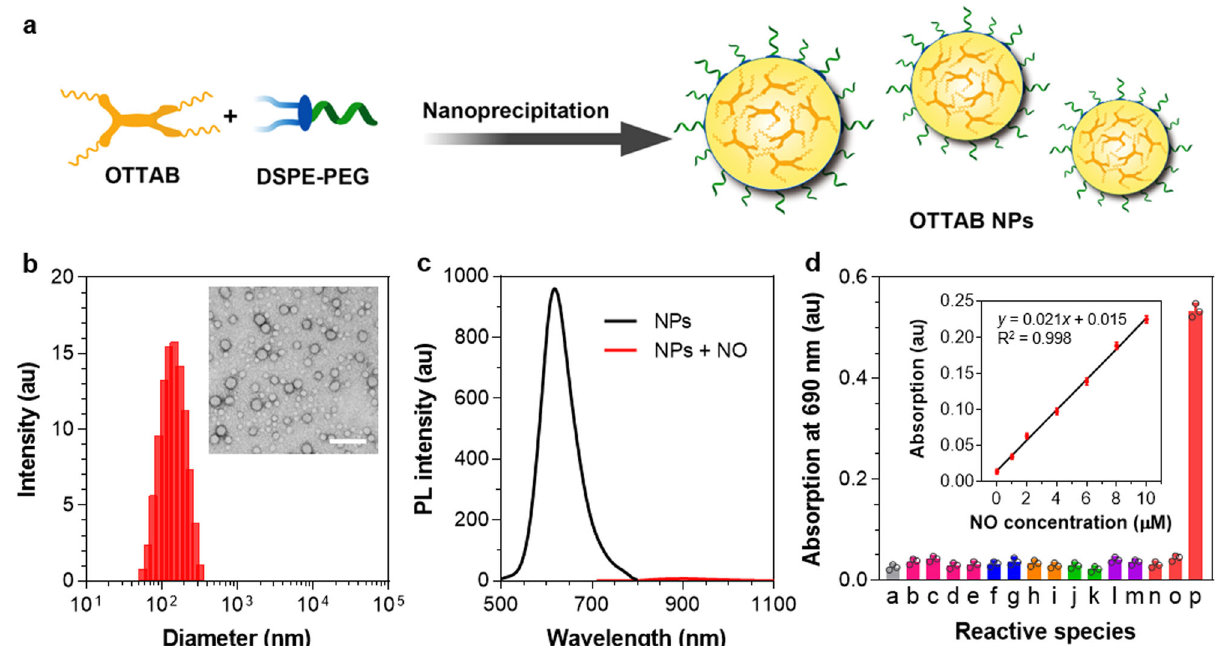
Fig. 4 Characterizations and reactivity of the NPs. a Schematic illustration showing the nanoprecipitation method. b Representative DLS and TEM results of the NPs. Scale bar: 500 nm. c PL spectra of OTTAB NPs (10 − 5 M) before and after NO treatment (The excitation wavelengths before and after NO treatment are 460 and 680 nm, respectively.) d Changes of the absorption intensity of OTTAB NPs (2 × 10 − 5 M) at 690 nm with the treatment of different species. a: no treatment, b: Ca 2 + , c: Fe 2 + , d: Fe 3 + , e: Cu 2 + , f: GSH, g: Hcy, h: H 2 O 2 , i: • OH, j: O 2 − , k: ClO − , l: SO 3 2 ‒ , m: H 2 S, n: NO 3 − , o: ONOO − , p: NO. The concentrations of all the species were 1 mM. Inset shows the relationship between the absorption intensity of OTTAB NPs (2 × 10 − 5 M) at 690 nm and the concentration of NO. Data are presented as mean ± s.d. ( n = 3 independent